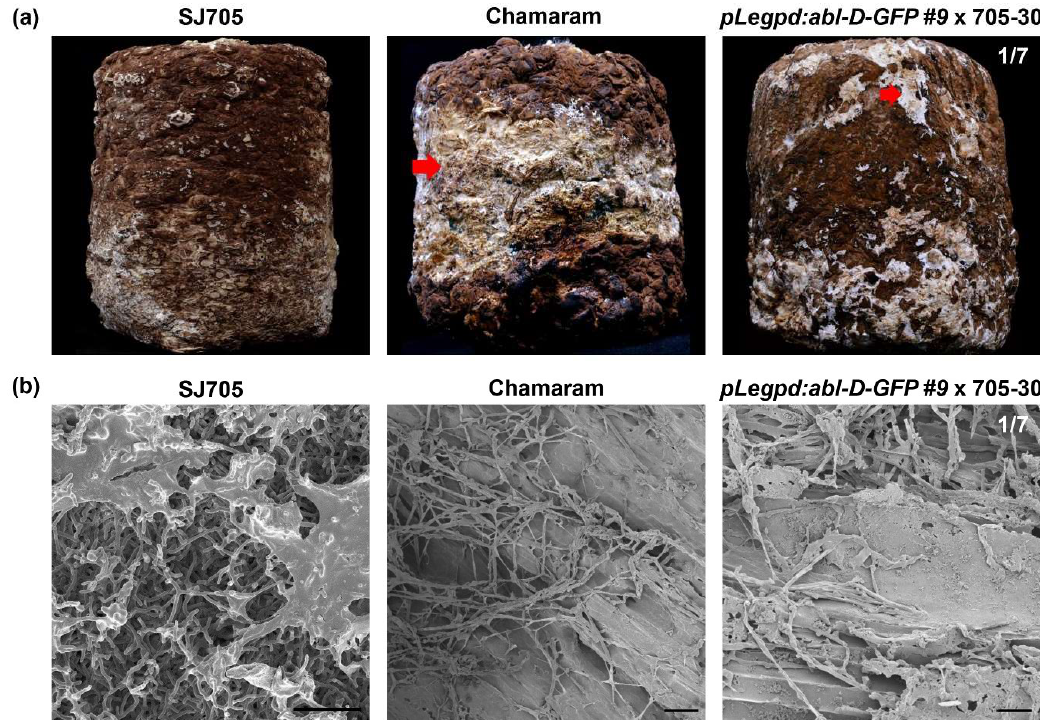
Figure 4. Mycelial brown film phenotype in transgenic strains overexpressing abl - D -GFP. ( a ) Mycelial brown film formation on sawdust media in the transgenic line, wild-type SJ705, and Chamaram. Images were taken after cultivation in conditions conducive to abnormal browning induction. The abnormal brown mycelial film is indicated by the arrow. ( b ) Scanning electron microscopy of mycelia from SJ705, Chamaram, and the pLegpd:abl-D-GFP dikaryotic transgenic line. Scale bar = 20 µm.